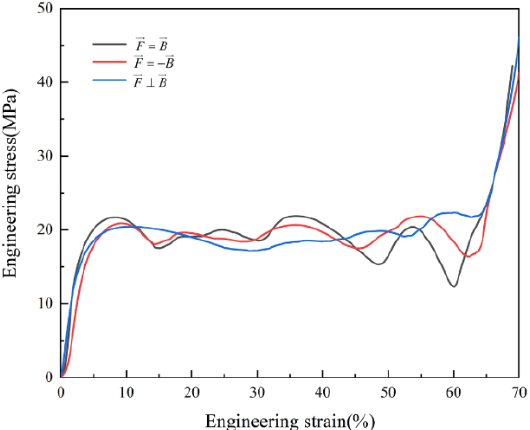
Figure 9. Stress – strain curve related to building direction: The compression direction is consistent with the construction direction, 𝐹⃗ = 𝐵⃗⃗ ; the compression direction is opposite to the construction direction, 𝐹⃗ = −𝐵⃗⃗ ; the compression direction is perpendicular to the construction direction, 𝐹⃗ ⊥ 𝐵⃗⃗ .